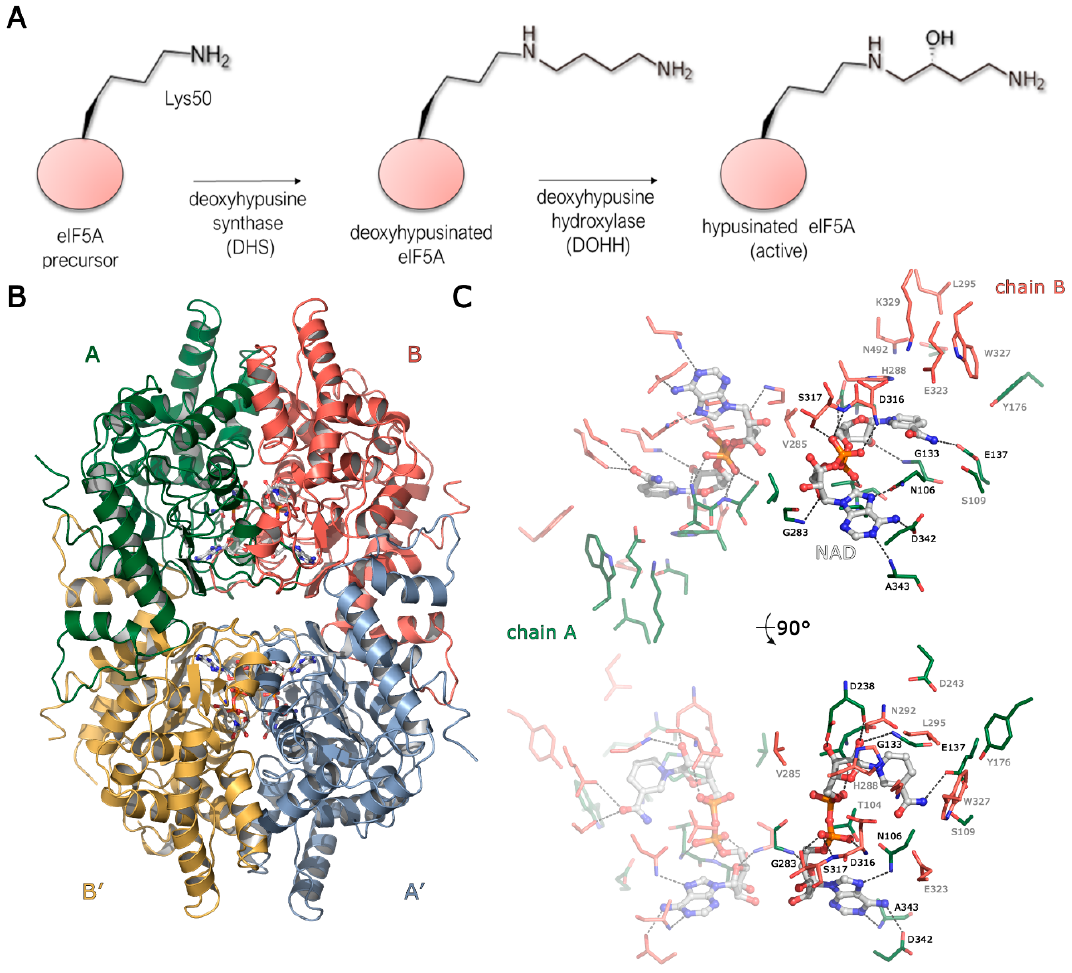
Figure 1. A deoxyhypusine synthase (DHS) overview. ( A ) A schematic representation of the hypusination pathway with DHS catalysing the first step, i.e., the transfer of the 4-aminobutyl moiety from spermidine (SPD) to a specific lysine side chain of eukaryotic initiation factor 5A (eIF5A) and deoxyhypusine hydroxylase (DOHH) finalising the modification by deoxyhypusine oxidation. ( B ) The structural organisation of the DHS tetramer. The tetramer is formed by two dimers with one (A-B, coloured green and red) observed in the asymmetric unit (ASU) of the crystal and the second dimer (A (cid:48) -B (cid:48) , coloured blue and yellow) observed by crystallographic symmetry. Ligands are shown as sticks, to highlight the locations of active sites. ( C ) A close-up view of the active sites formed at the dimer interface in the binary DHS-nicotinamide adenine dinucleotide (NAD) complex. Two NAD molecules are bound symmetrically and coordinated by residues from both subunits. The co-factor is shown as balls and sticks with carbon atoms coloured white, and residues from chains A and B are shown as sticks, with carbon atoms in green and red respectively. Residues binding the co-factor are black, and residues completing the active site are grey. For clarity, one of the active sites is